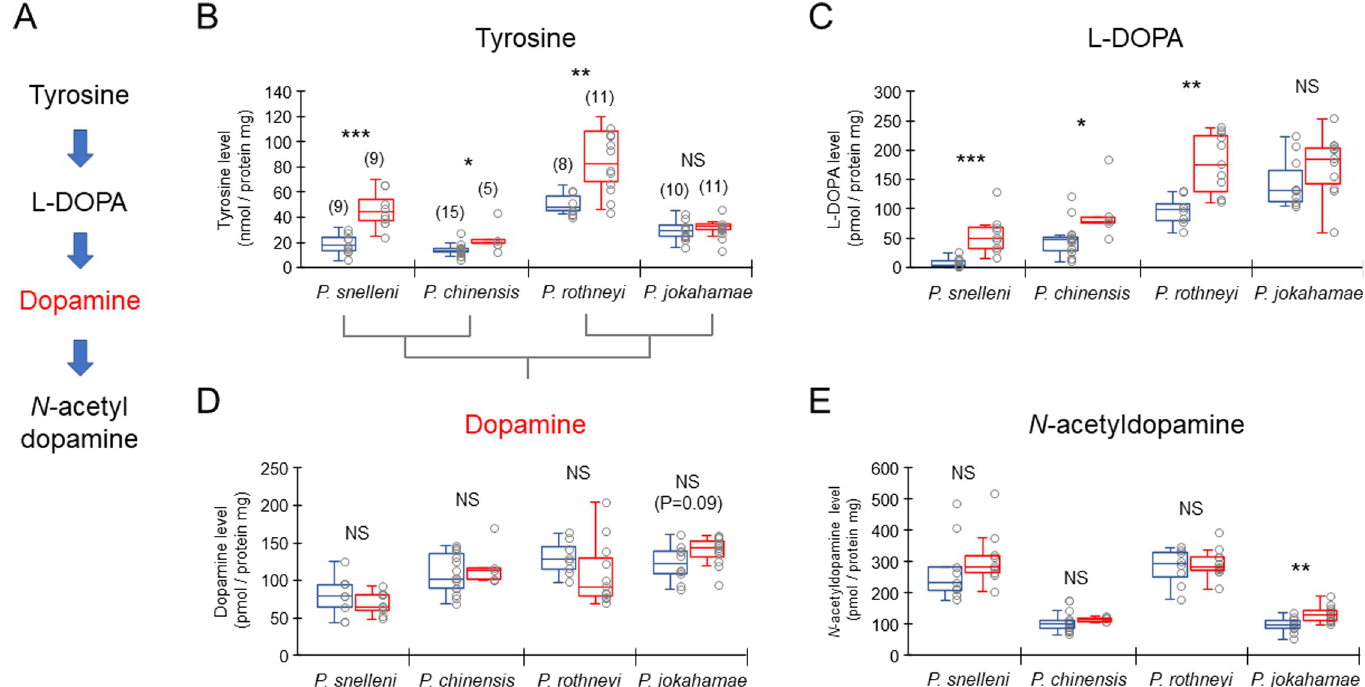
Fig 2. Amounts of dopamine-related substances in the brains of newly emerged workers and gynes in four species of Polistes paper wasps. (A) Dopamine synthetic pathway, (B) tyrosine levels, (C) L-DOPA levels, (D) dopamine levels, and (E) N -acetyldopamine levels. Blue and red box plots indicate workers and gynes, respectively. Numbers in parentheses in the graph indicate the number of samples examined. The number of samples is the same for four substances. Asterisks in the graph indicate significant differences between workers and gynes ( � : P < 0.05, �� : P < 0.01, ��� : P < 0.001, NS: not significant, P > 0.05). The phylogenetic relationship is indicated below the X-axis in